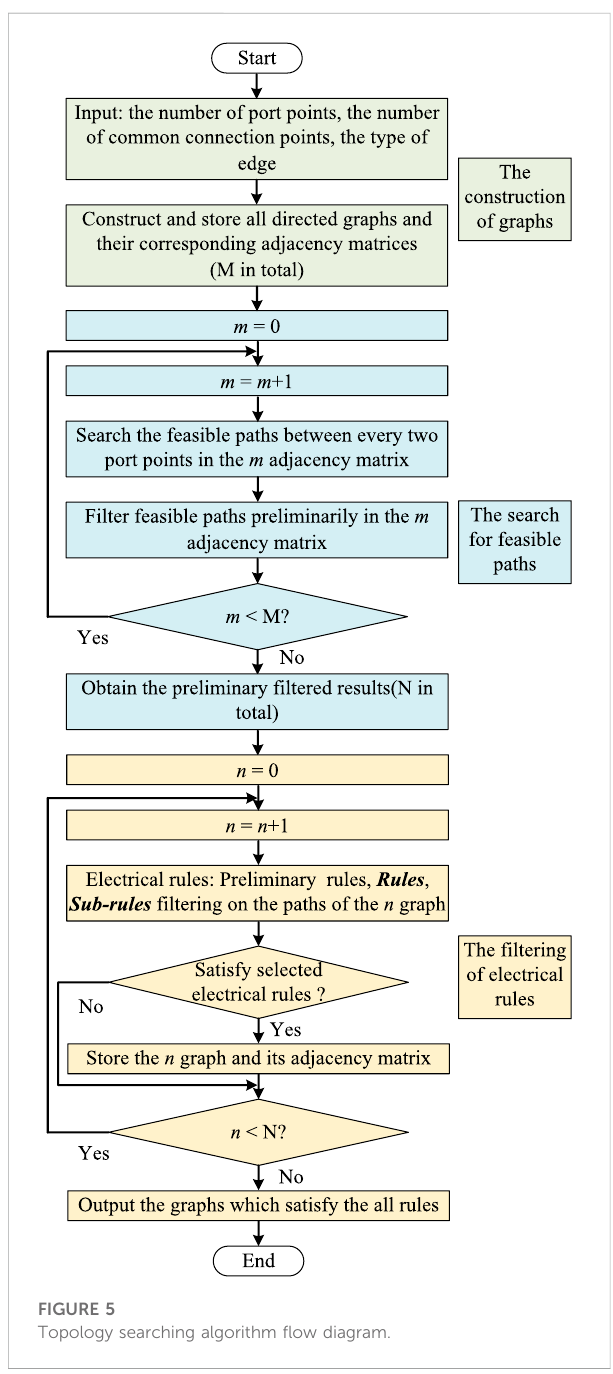
FIGURE 5 Topology searching algorithm fl ow diagram.